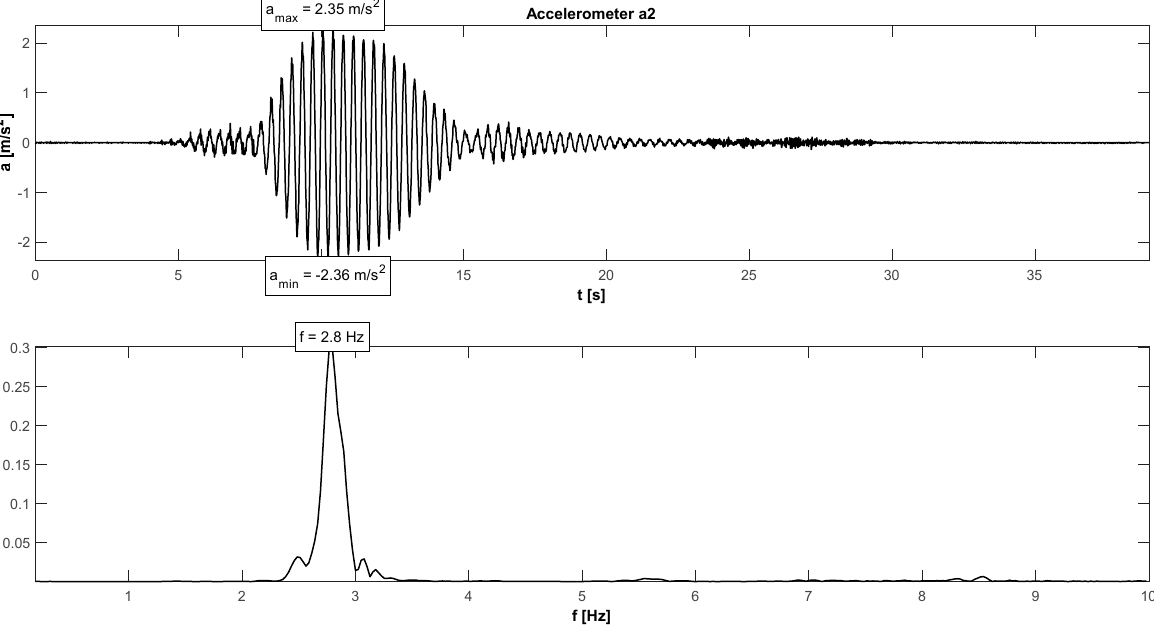
Figure 26. Signal of vertical vibrations in the time and frequency domain registered for 10 people running.